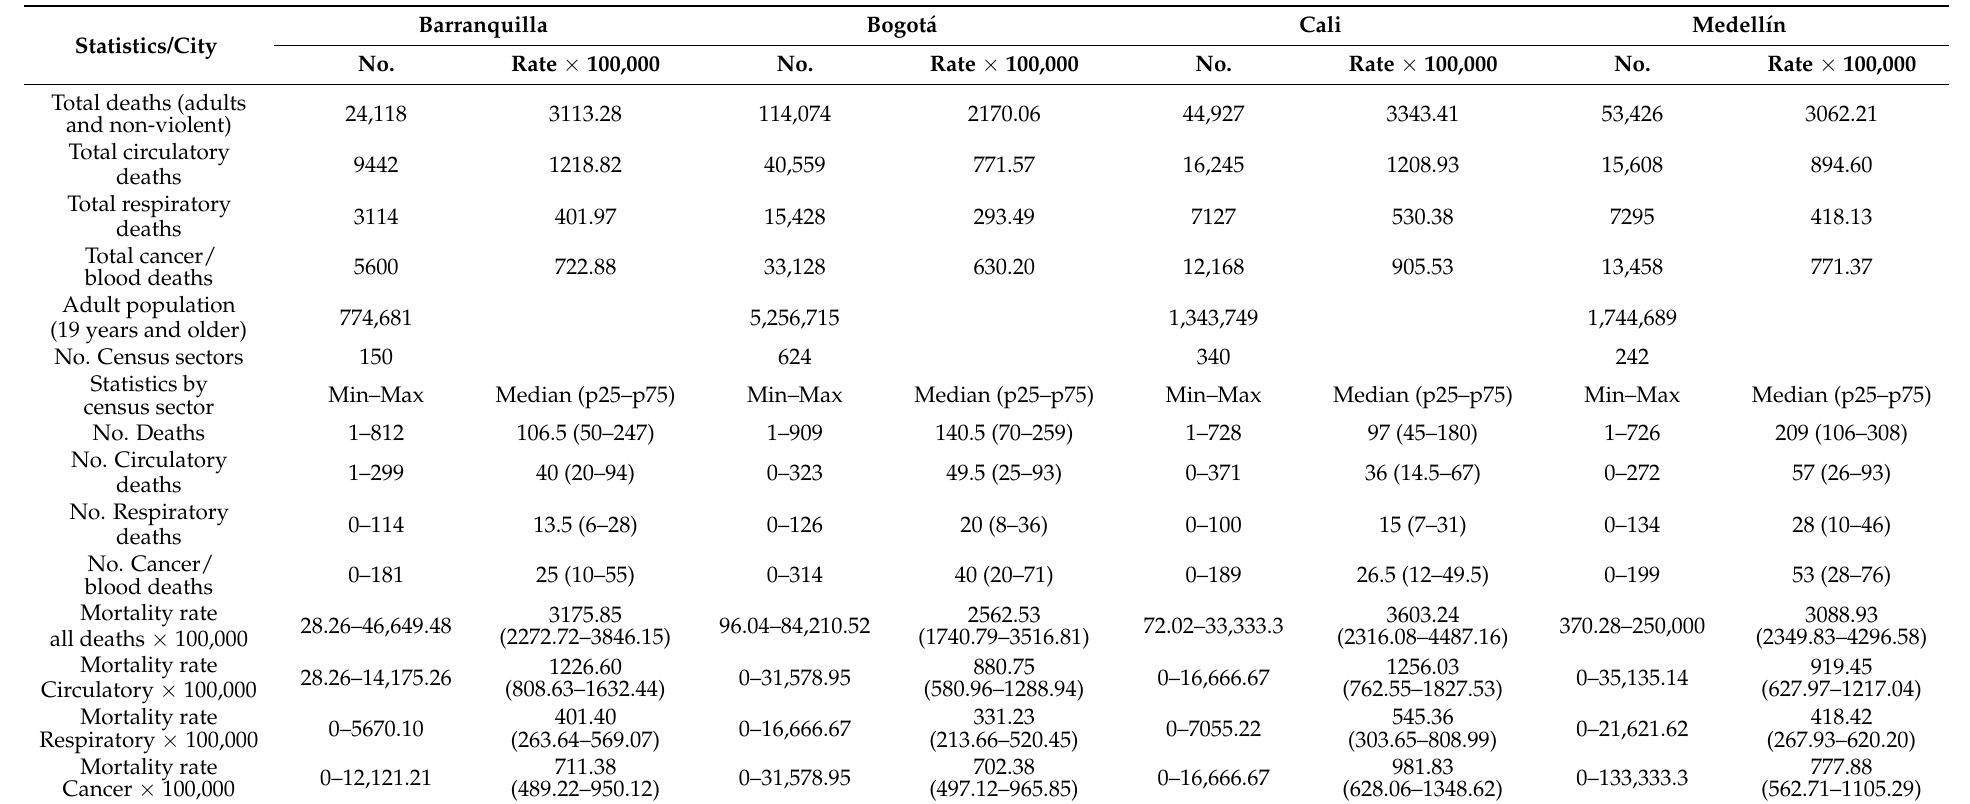
Table 1. Number of deaths and crude mortality rates for all deaths and specific causes of death at the city and census sector level for four cities in Colombia,